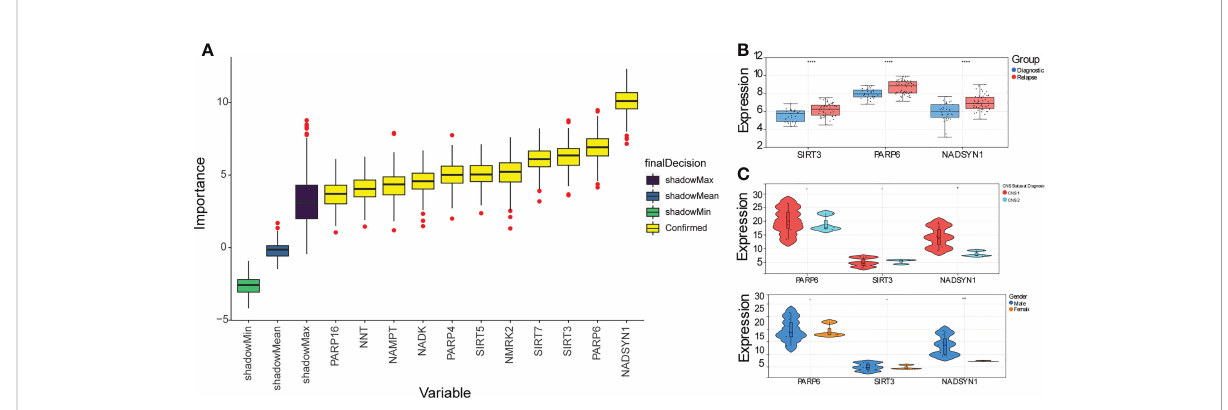
FIGURE 2 Identi fi cation of 3 biomarkers. (A) Box plot of importance of 11 DE-NMRGs through Random forest algorithm. (B) The expression pro fi le of 3 biomarkers in initially diagnosed and relapse samples. **** represents p < 0.0001. (C) The expression levels of 3 biomarkers within different clinical traits ( p < 0.05). * represents p < 0.05, ** represents p < 0.01, - represents no signi fi cant